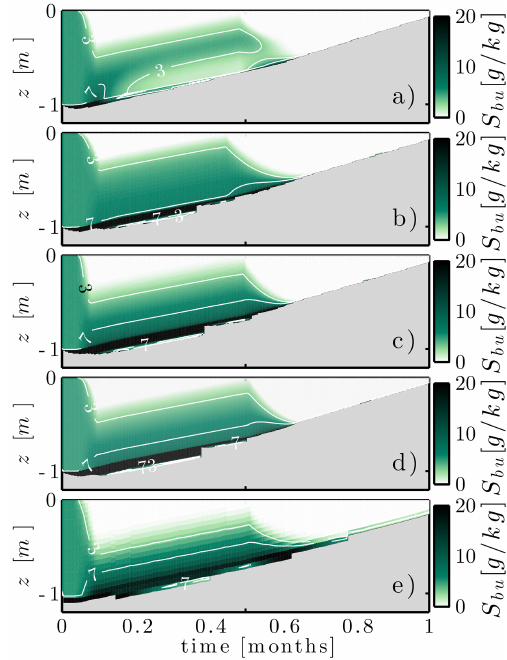
Figure 7. Salinity evolution of the idealized melting experiments in which one specific parameter or setting has been changed from the default values (default model results shown in Fig. 6, experiment description can be found in Sect. 3, default settings are listed in Table 1). The 3 and 7gkg − 1 contour lines are included. (a) Gravity drainage is included, which is otherwise disabled in the experiment. (b) The ratio of horizontal to vertical hydraulic resistance β is 0.2 instead of 1.0. In (c) the ratio of horizontal to vertical hydraulic resistance β is 5 instead of 1.0. In (d) the vertical spatial resolution (cid:52) z 0 is 2mm instead of 1cm, and in (e) the vertical spatial resolution (cid:52) z 0 is 5cm instead of